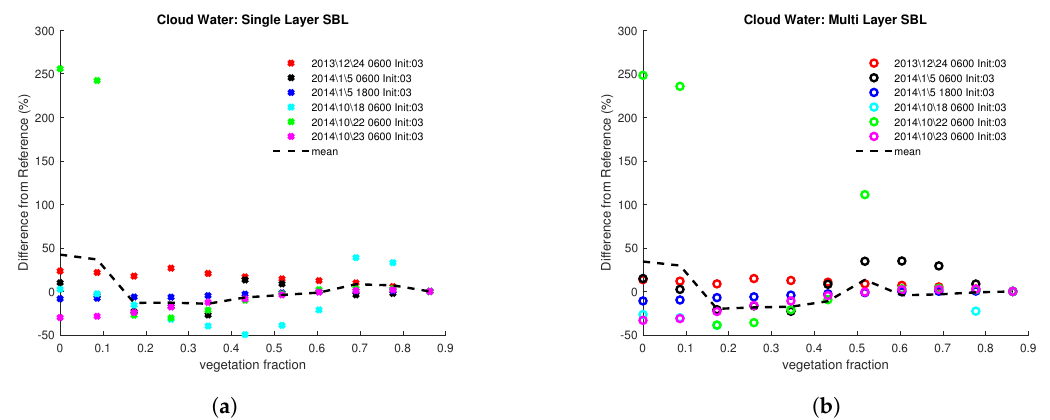
Figure 8. Percent difference of temporally averaged 117 m cloud water from the 86.3% vegetation case as a function of vegetation percentage for single layer SBL ( a ) and multilayer SBL scheme ( b ). The black dashed lined indicates the mean for each vegetation fraction.